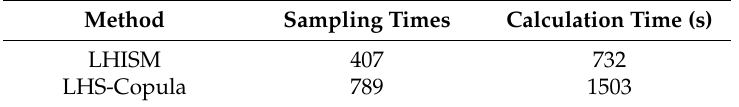
Figure 7. Cumulative distribution curve of I 34 . Table 1. Comparison of sampling times and calculation times of the two methods.